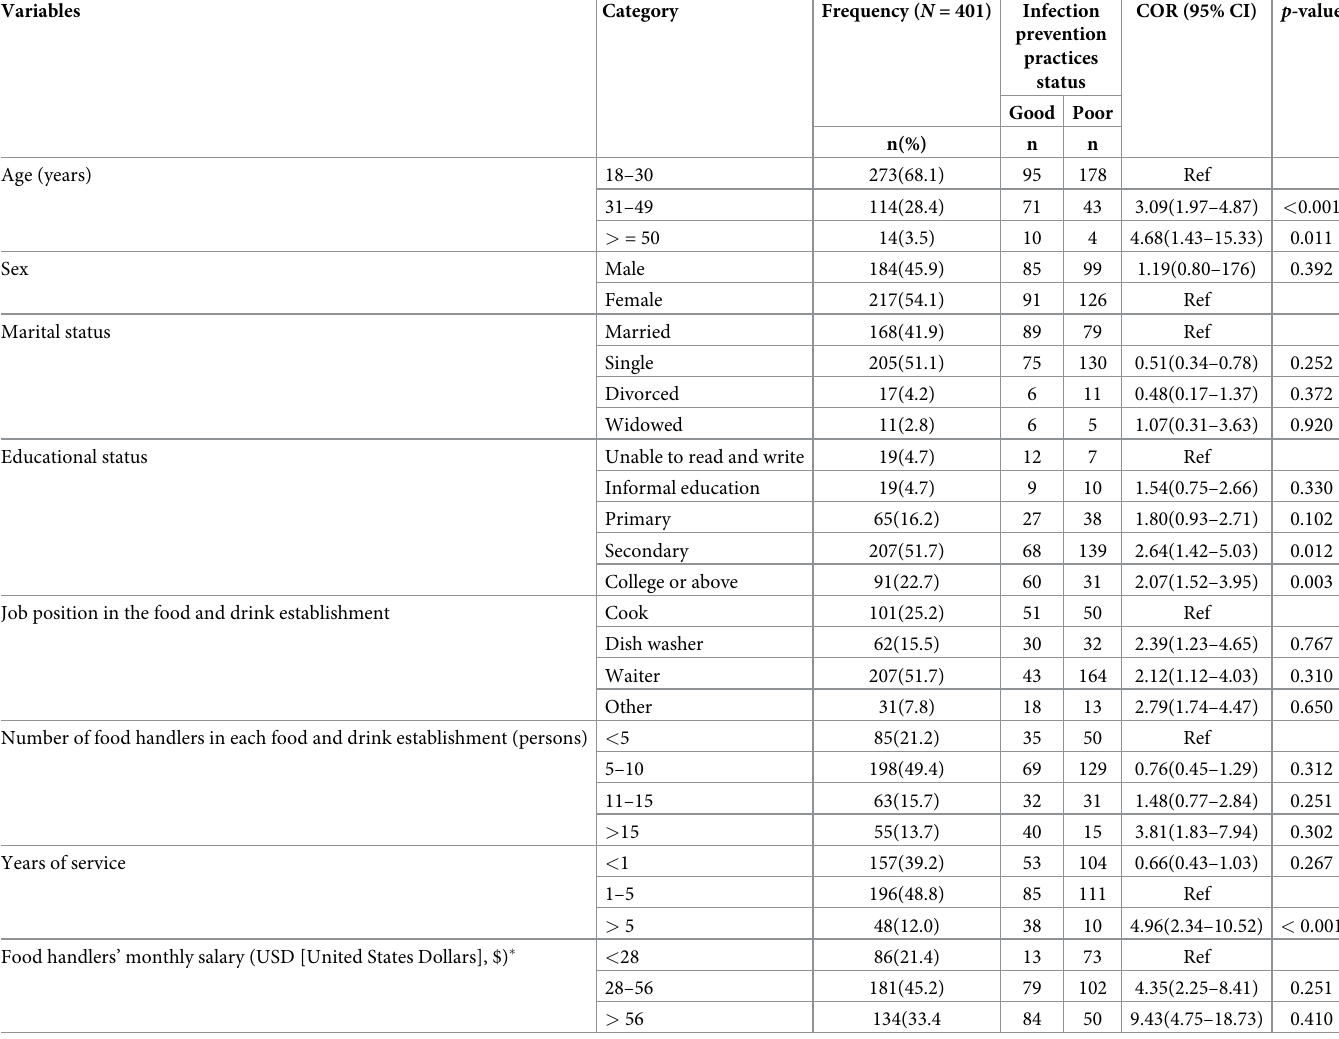
Table 1. Socio-demographic characteristics and bivariable analysis with infection prevention practices among food handlers at food and drink establishments in Dessie City and Kombolcha Town, Northeastern Ethiopia, July–August 2020.